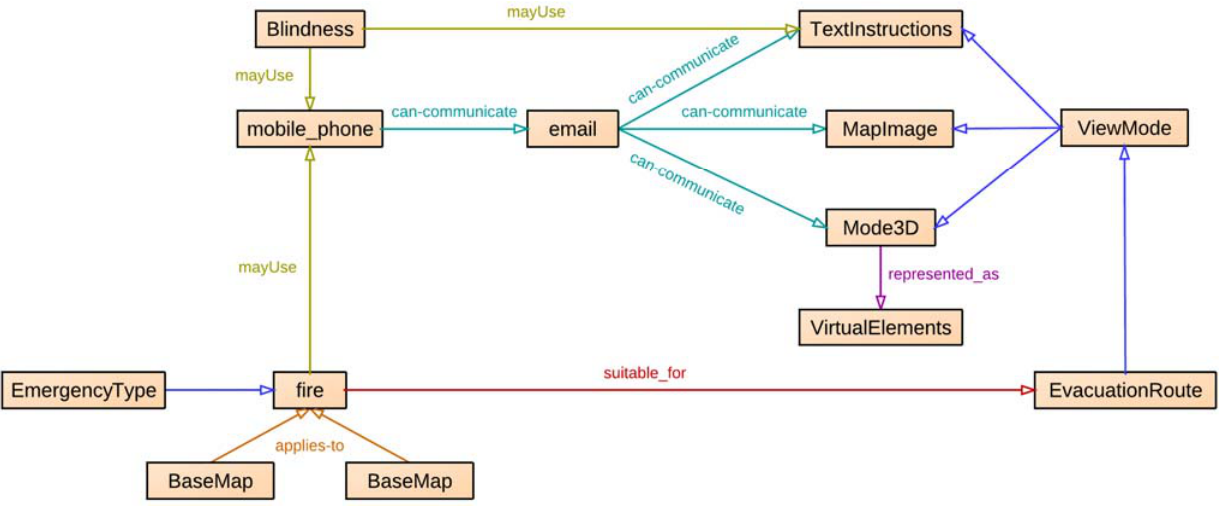
Figure 3. NERES: relationships of the evacuation plan data model with